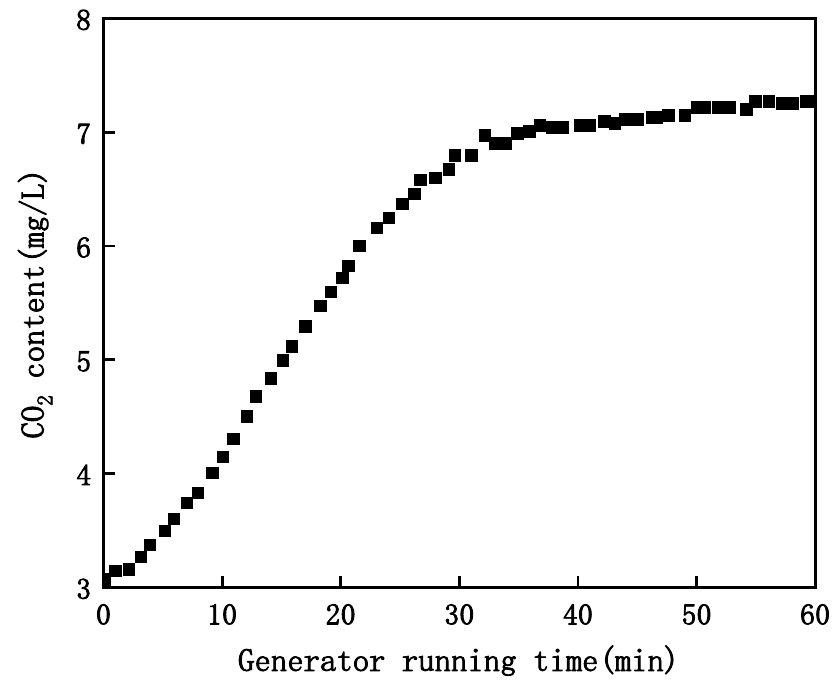
Figure 10. Variation trend of the CO 2 content in the MNB water.